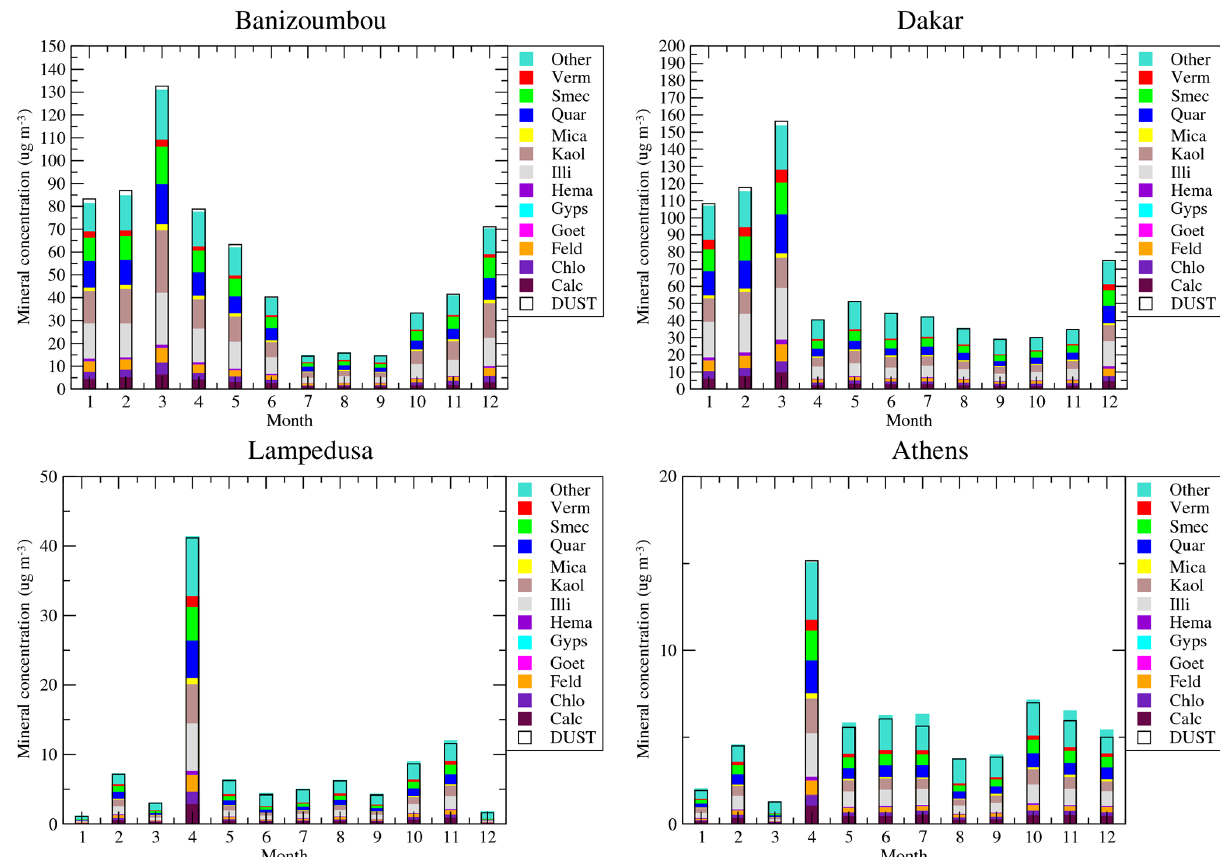
Figure 4. Monthly averaged modelled surface concentrations of the mean DUST species and all mineralogical species (micrograms per cubic